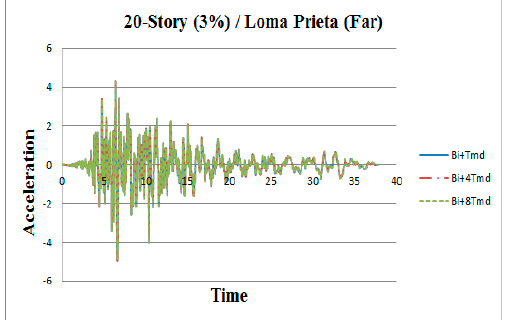
Figure A8. Acceleration time histories for top story of 20-story building under the Loma Prieta (far-fault) earthquake.